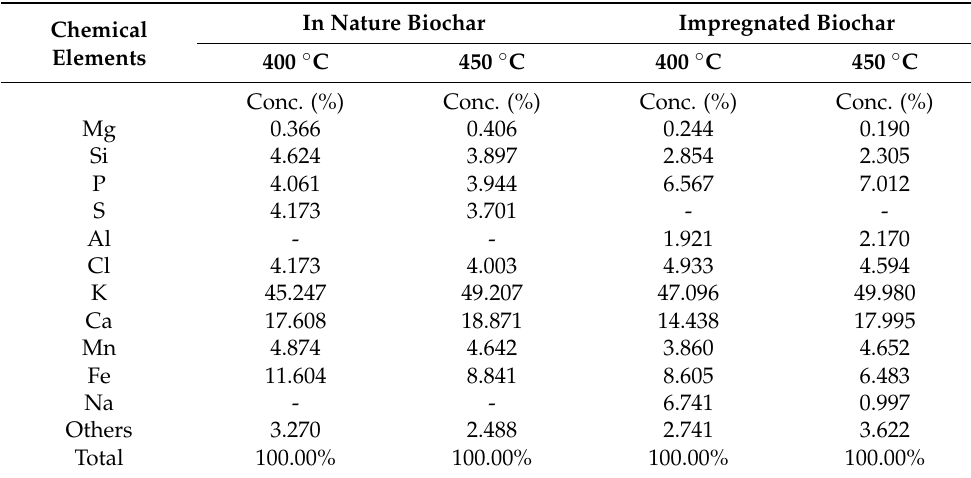
Table 5. FRX analysis of biochar impregnated and in